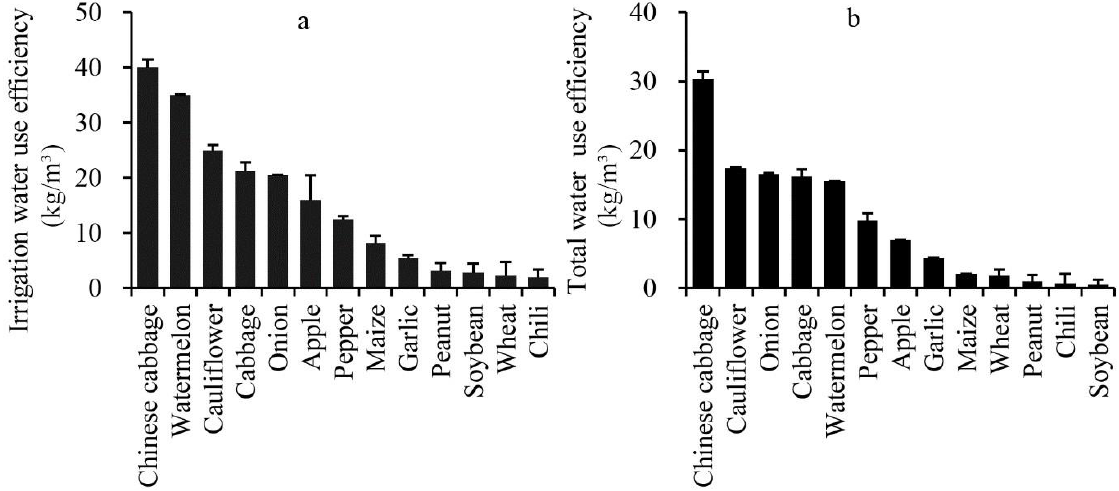
Figure 4. Water use efficiency of different crops (bars represent the standard deviations for different farmers, ( a ) is the irrigation water use efficiency and ( b ) is the total water use efficiency).